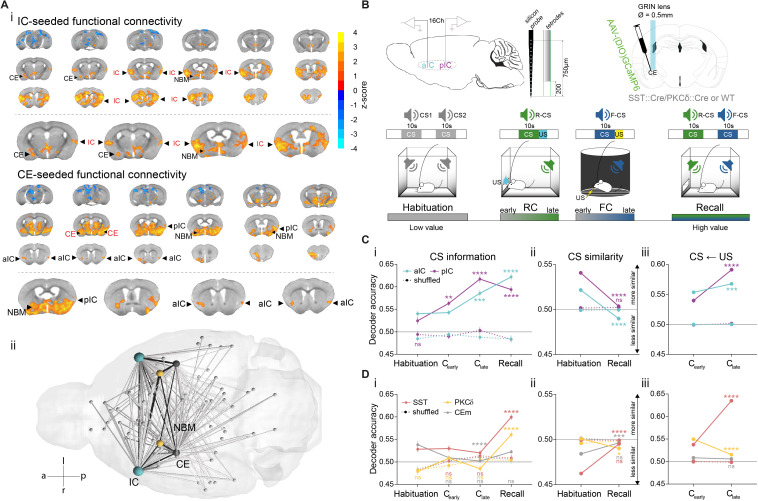
IC and CE are coupled and acquire information on task stimuli.(A) (i) Seed-based functional connectivity of the bilateral IC (top) showed coupling to CE and NBM. Seeding the CE (bottom) showed coupling to the aIC, pIC and NBM (radiological view). Significant z-scored correlations to seed nodes are displayed in orange (positive) and blue (negative). (ii) Bottom-view of region-based functional connectivity of ROIs (see correlation matrix in Figure 1—figure supplement 1B). Edge thickness depicts connectivity strength. Only nodes and edges with significant correlations to IC and CE are shown. Edges between IC, CE, and NBM are highlighted in black. (B) Schematic depiction of experimental recordings. Top, left: mice were chronically implanted with single-site silicon or multi-site tetrode probes in aIC and pIC. Top, right: SST::Cre, PKCδ::Cre, or wild-type mice were chronically implanted with a GRIN lens above CE in animals injected with AAVs carrying GCaMP6. Bottom: Experimental timeline of the four-stage discriminatory Pavlovian learning paradigm. (C) (i) Decoder accuracy (Da) of a multi-layer perceptron (MLP) classifier trained to detect CS information in the activity of 200 random draws of 40 neurons per IC subregion for each CS and stage. Mean of both CSs is shown (significant stage x subregion interaction in a two-way ANOVA F9,6384=13.69, p<0.0001). * Indicates significant differences from the respective habituation stage. (ii) MLP, trained on 400 random draws of neurons as in (i), to detect R(F)-CS, but applied on F(R)-CS within the habituation and recall stages (significant stage x subregion interaction in a two-way ANOVA, F3,6392=42.10, p<0.0001). * Indicates significant differences from the habituation stage. (iii) Mean Da of an MLP trained on the activity of 400 random draws of 40 neurons per IC subregion to detect R-US or F-US applied on R-CS or F-CS, respectively, within the Cearly and Clate stages (significant stage x subregion interaction in a two-way ANOVA F3,6392=50.14, p<0.0001). * Indicates significant differences from the Cearly stage. (D) (i) Da of an MLP trained to detect CS information in the activity of 200 random draws of neurons for each CE population (30 neurons for each CESST and CEPKCδ and seven neurons for CEm), CS and stage. Mean of both CSs is shown (significant stage x population interaction in a two-way ANOVA F15,9576=9.30, p<0.0001). * Indicates significance as in Ci. (ii) MLP, trained on 400 random draws of neurons as in (i), to detect R(F)-CS, but applied on F(R)-CS within the habituation and recall stages (significant stage x population interaction in a two-way ANOVA, F5,9588=30.40, p<0.0001). (iii) Mean Da of an MLP trained on the activity of 400 random draws of neurons (30 neurons each for CESST and CEPKCδ, and 10 from CEm) to detect R-US or F-US and applied on R-CS or F-CS, respectively, within the Cearly and Clate stages (significant stage x population interaction in a two-way ANOVA F5,9588=339.60, p<0.0001). Holm-Sidak post hoc for all analyses, ****p<0.0001. Only non-significant differences to shuffled data are explicitly indicated (‘ns’). All data presented as mean ± SEM. Full statistical report in Appendix 1—table 1.Figure 1—source data 1.Decoding accuracy of an MLP classifier on iterative draws of neurons from IC and CE populations.